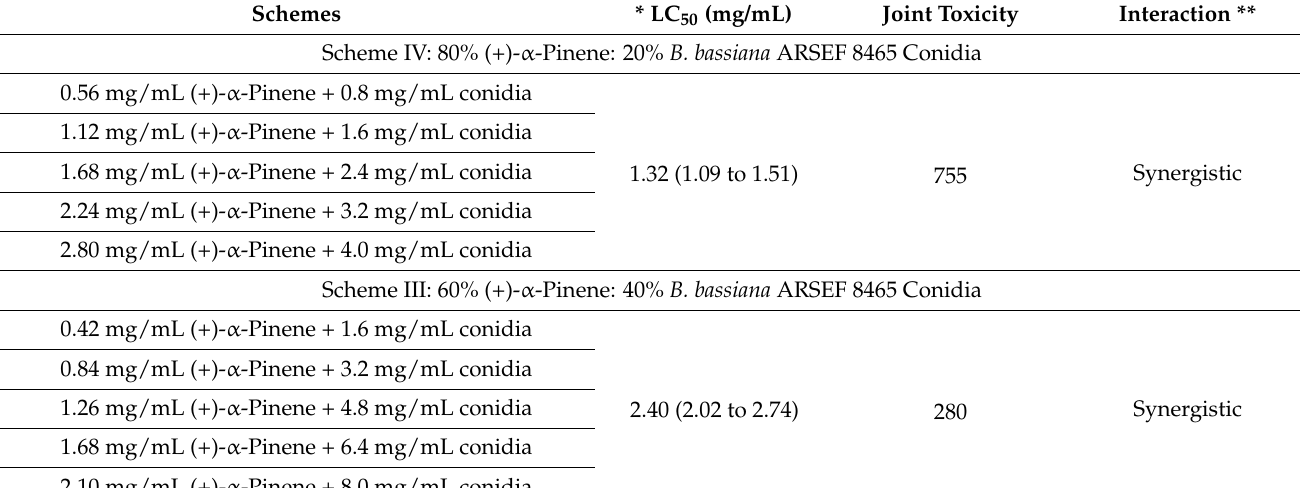
Table 5. Interaction (Synergistic or Antagonistic) between (+)- α -Pinene and B. bassiana ARSEF 8465.